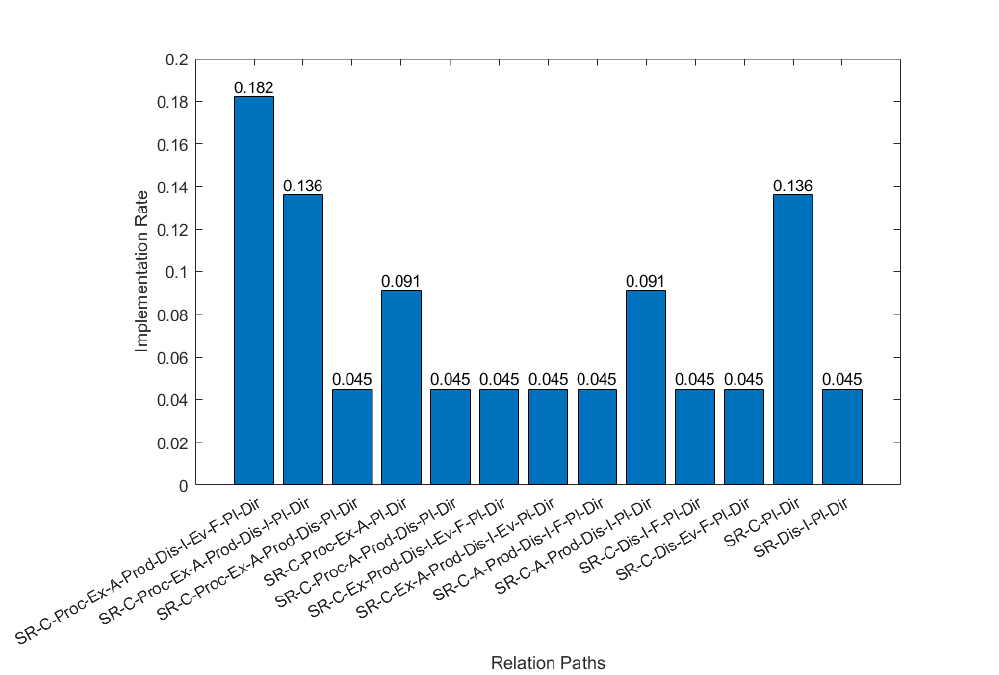
Figure 8. Implementation Rate for each Relation Path in existing CTI Systems.